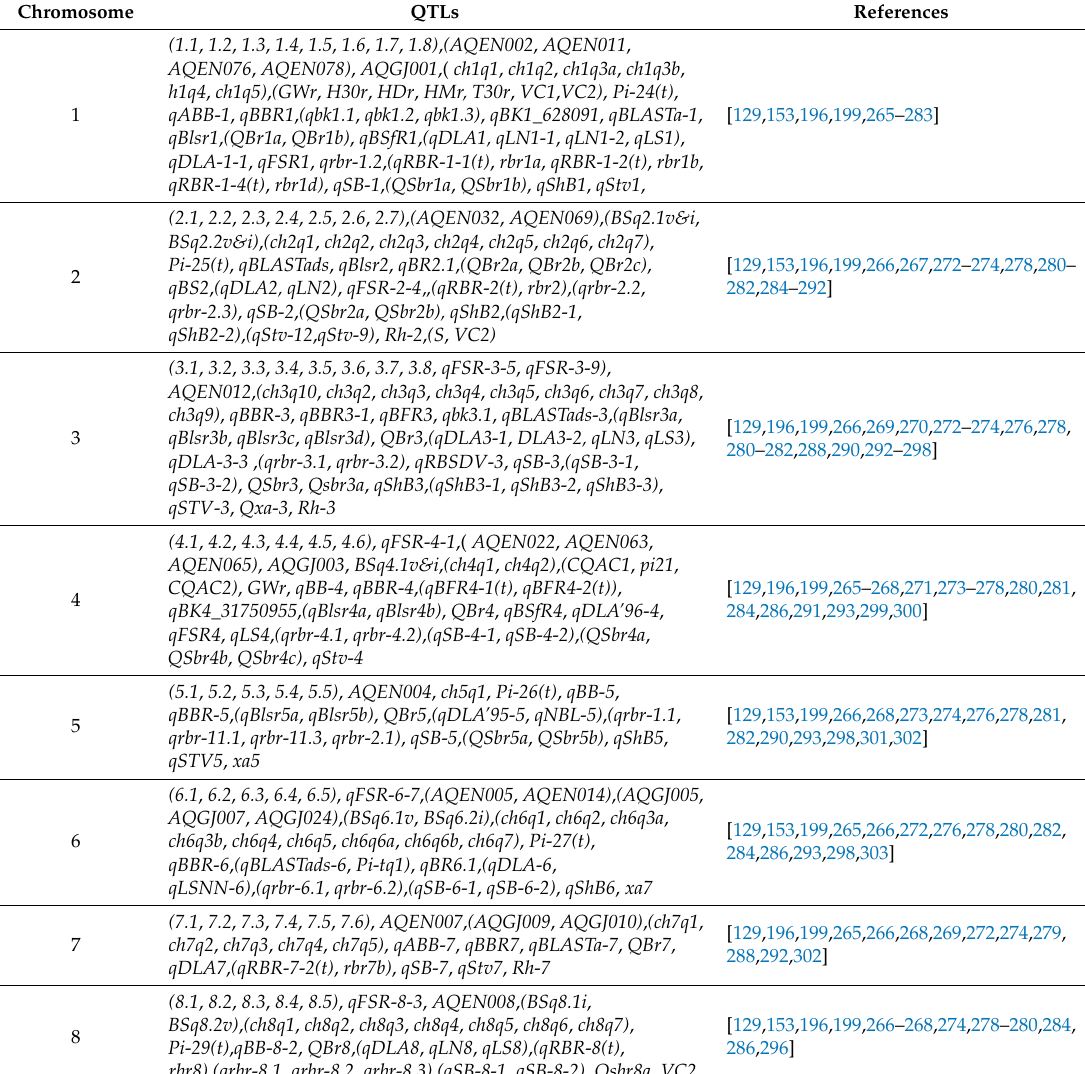
Table 2. Chromosome wise list of identified QTLs against various pathogen induced diseases in